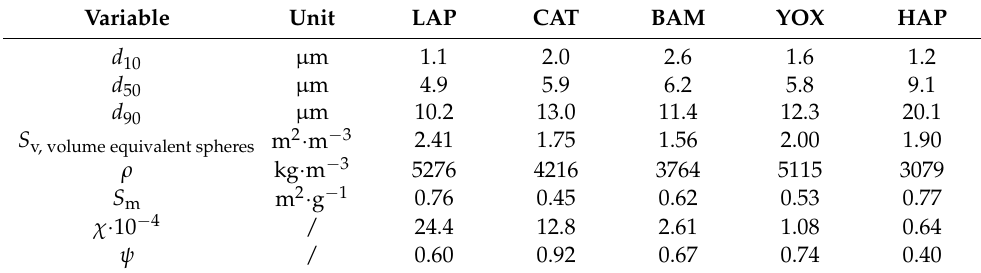
Table 2. Summary of the investigated phosphors’ physical properties: 10th percentile diameters ( d 10 ), median diameters ( d 50 ), 90th percentile diameters ( d 90 ) and surface area of volume equivalent spheres ( S v, volume equivalent spheres ), as determined with laser diffraction analysis, densities ( ρ ), obtained with gas displacement pycnometry, S m , calculated from nitrogen adsorption isotherms, estimated volume- weighed sphericities ( ψ ) and volumetric magnetic susceptibilities ( χ ), measured with a SQUID-VSM. Variable Unit LAP CAT BAM YOX HAP d 10 µ m